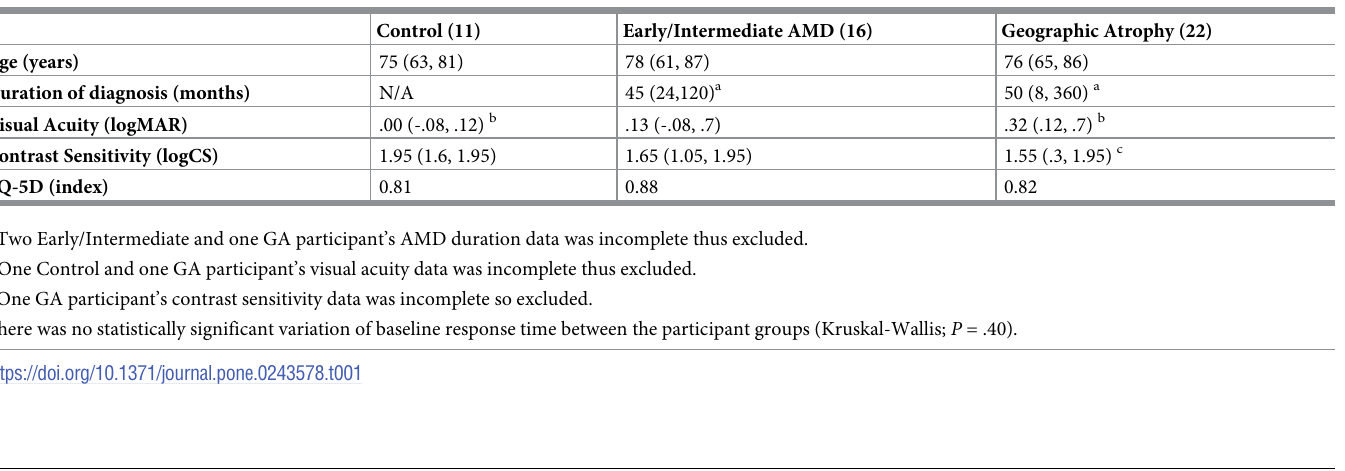
Table 1. Median (interquartile range; IQR) demographic and clinical data of